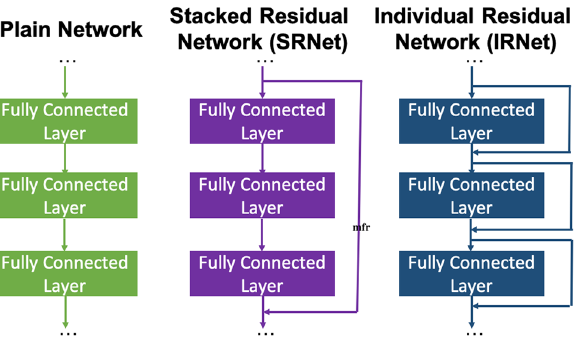
Figure 5. Design approach for IRNet. Plain Network is composed of sequence of fully connected layer, where each layer is composed of a dense layer followed by batch normalization 51 and ReLU 54 . Existing approach of residual learning places shortcut connection around each stack of multiple such layers where all the layers within each stack have same configuration (SRNet). The presented approach of individual residual network (IRNet) places shortcut connection around each layer which makes it easy for the model to learn the mapping of output materials property from the material composition and/or structure in the model input.